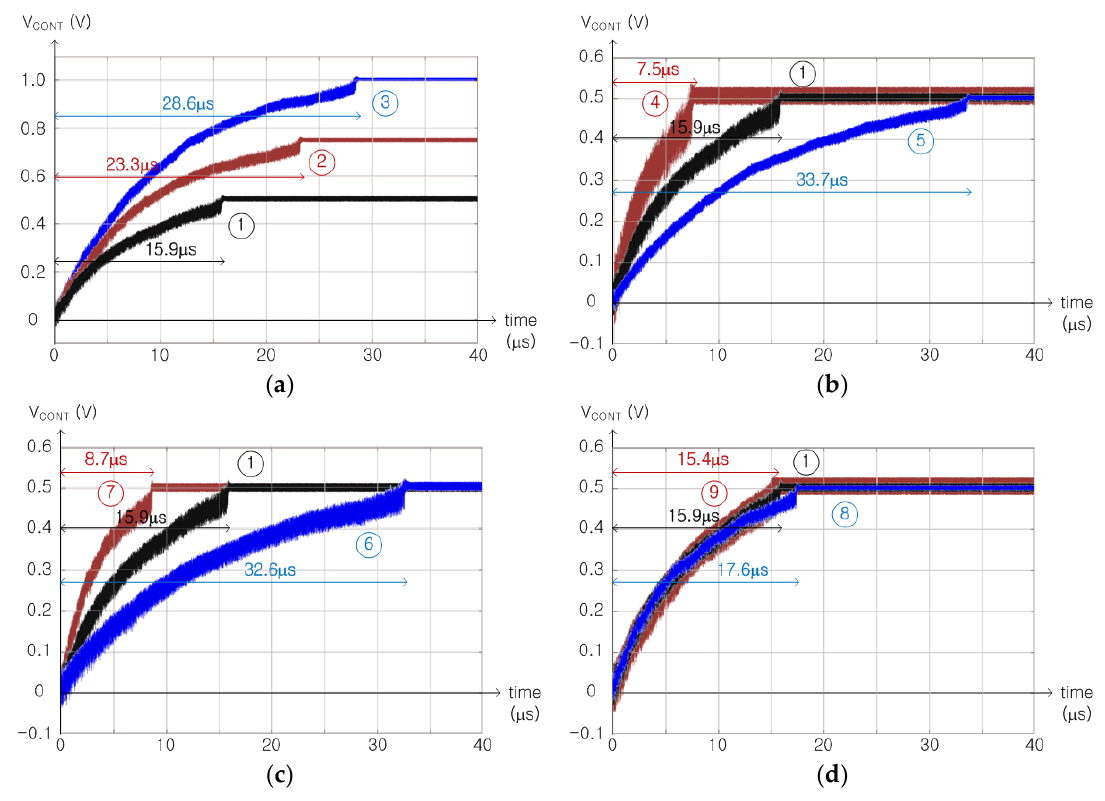
Figure 10. The simulated locking trajectories of V CONT when ( a ) f DATA , ( b ) I CP , ( c ) C 1 and ( d ) C 2 are varied. Table 1. The loop parameters and lock times.